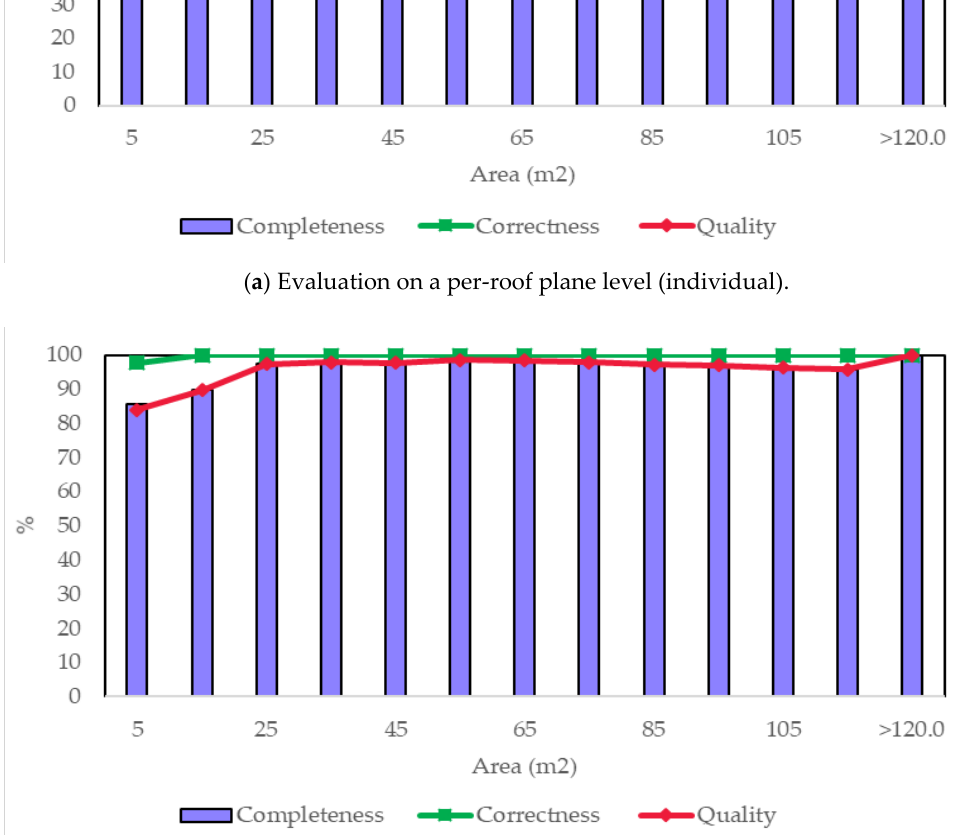
Table 7. Comparison of the final reconstruction performance (per-roof plane).